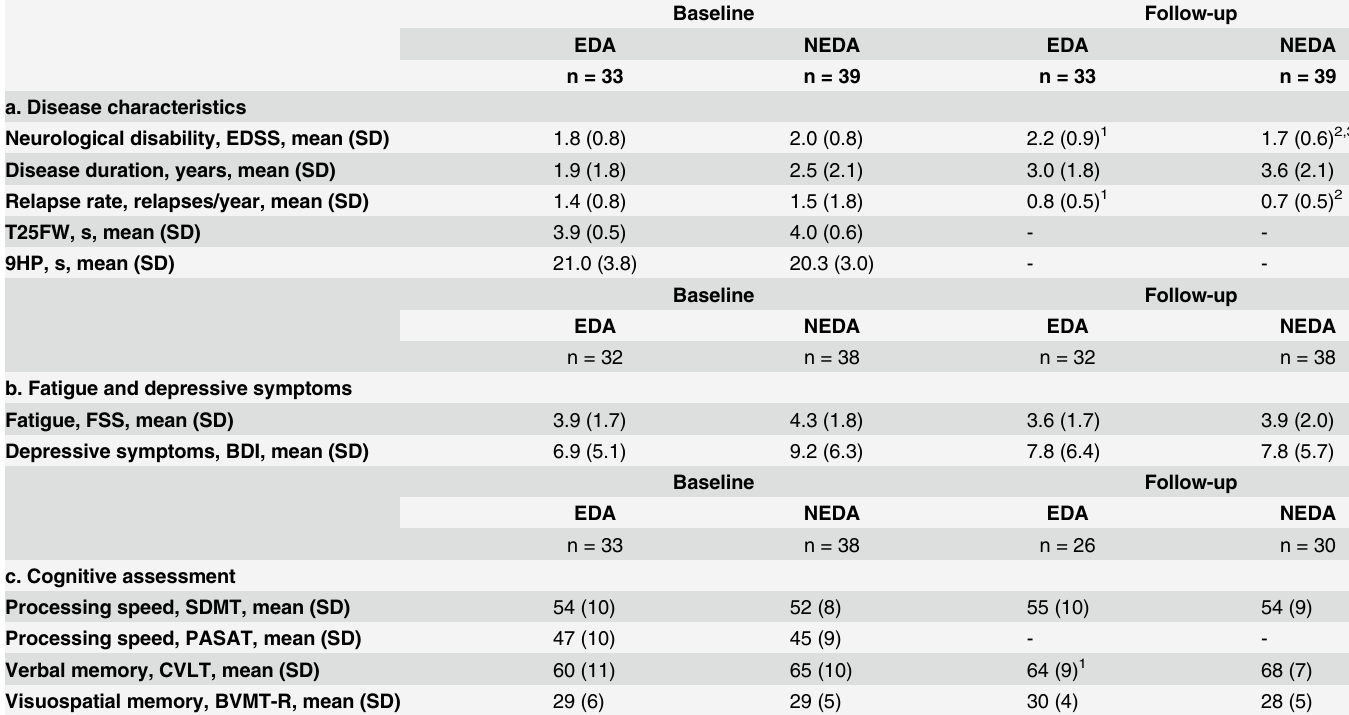
Table 2. Disease characteristics, fatigue, depressive symptoms and cognitive assessment of patients according to evidence of disease activity at baseline and